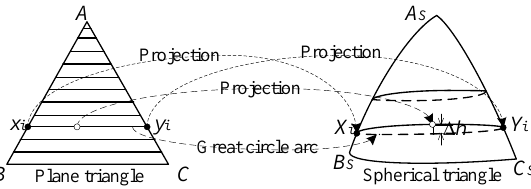
Figure 6. The mode of calculating the spherical line distortion by using projection method The